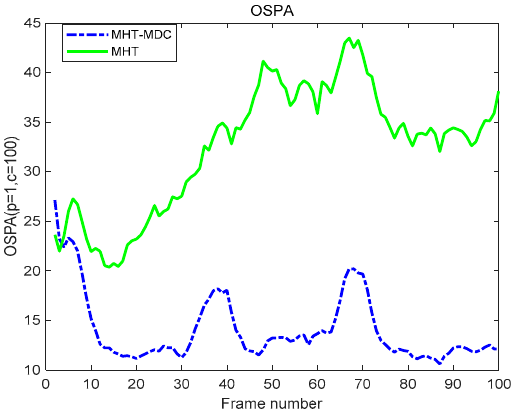
Figure 13. The OSPA distance of two algorithms in scenario 2.